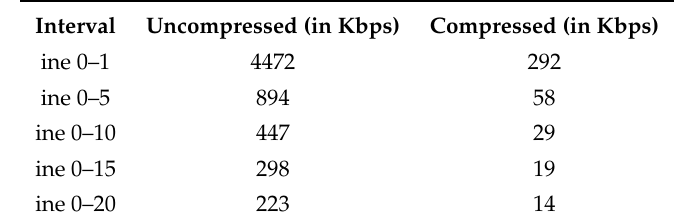
Table 2. The bandwidth required to send the biggest message of the network state using the communication mechanism of the proposed